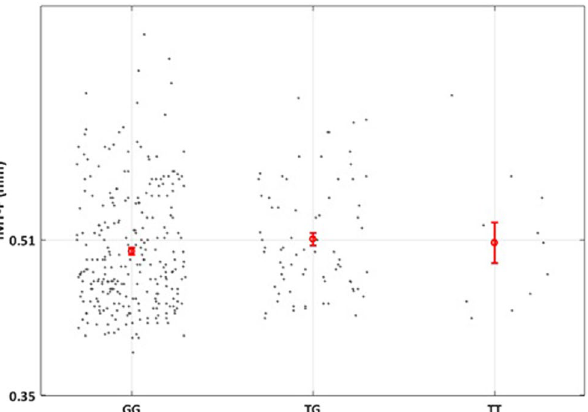
Figure 2. Mean values of intima media thickness of IMT-F according to the different genotypes of rs6918289 (GG vs TG vs TT) in the SFS population. Thin bars show standard